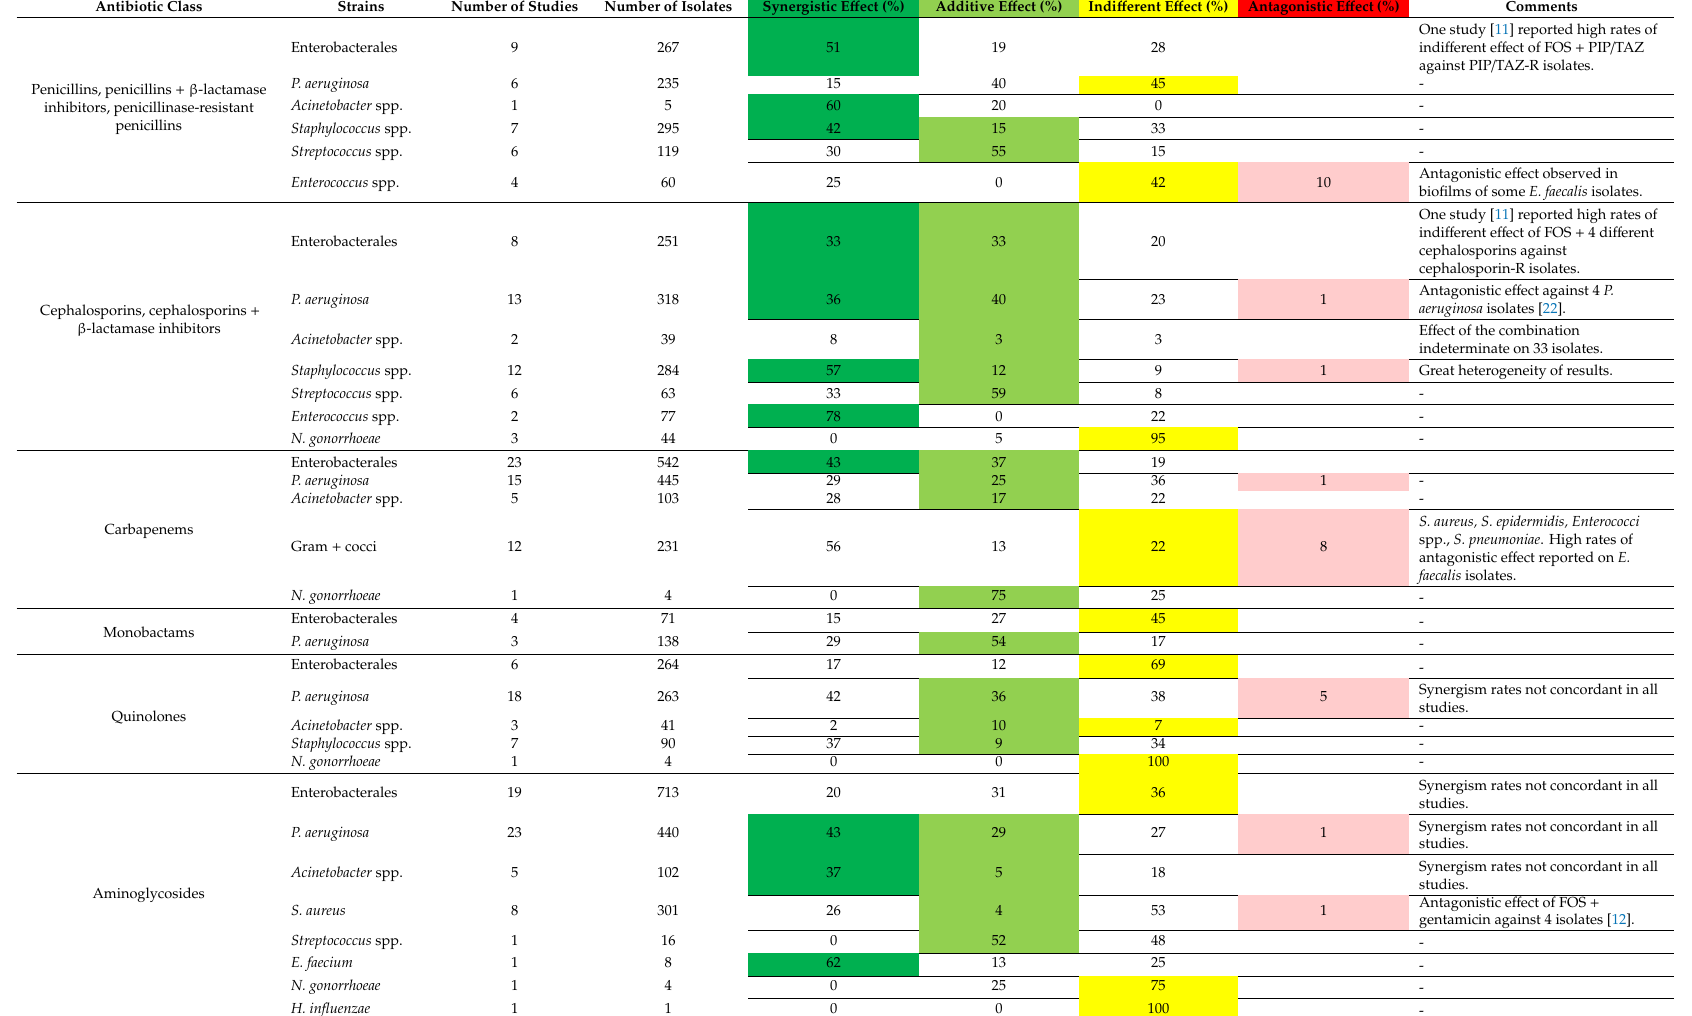
Table 15. E ff ect of FOS in combination with di ff erent antibiotics: